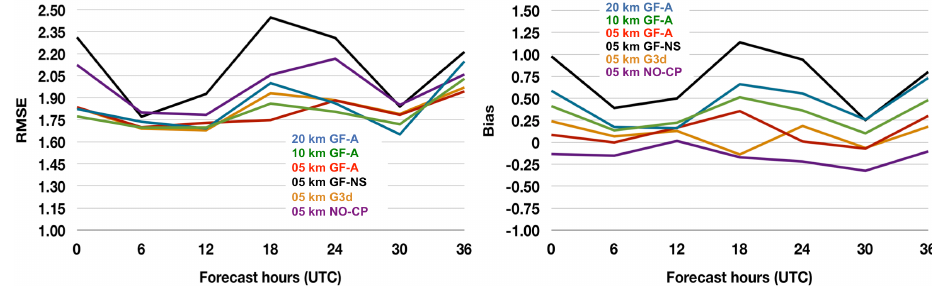
Figure 12. As in Fig. 7, except for Root Mean Square Error (RMSE) and mean error (Bias). Units are mm/6h